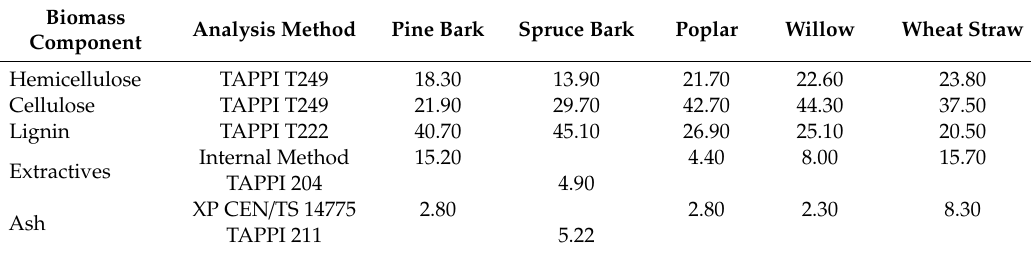
Table 2. Composition by chemical methods for the raw biomasses (wt.%, dry basis).